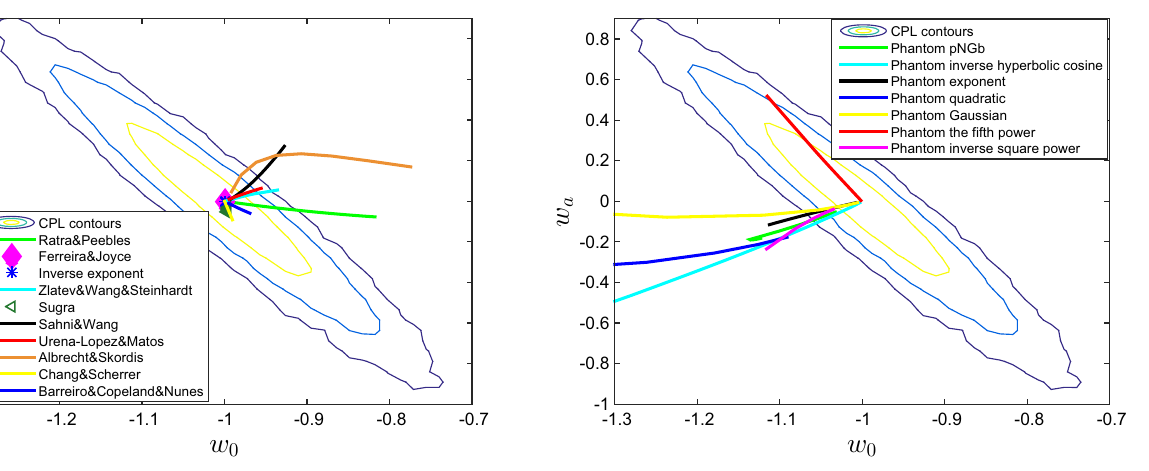
where each dark energy model is mapped in the CPL param- eter space. The CPL- Λ CDM contours in Figs. 1 and 2 repre- sent 1, 2, and 3 σ confidence levels for the CPL parametriza- tion derived by fitting the same H ( z ) , d A ( z ) , and f ( a )σ 8 data. In order to check how well the CPL